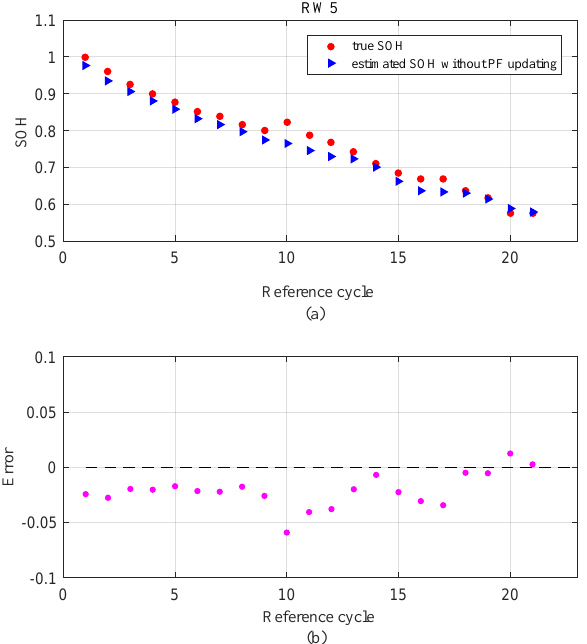
Figure 15. ( a ) SOH estimation results and ( b ) estimation errors for battery RW5 using indirect HIs without PF updating.